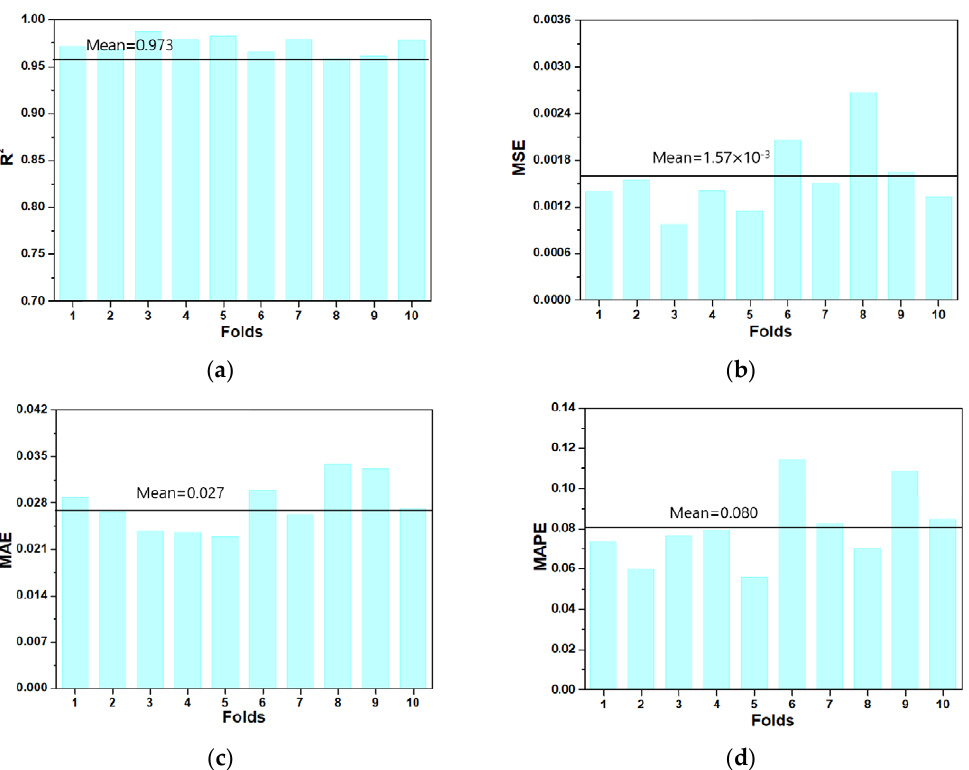
Figure 5. Results for 10-fold cross validation. ( a ) R 2 ; ( b ) MSE; ( c ) MAE; ( d ) MAPE.